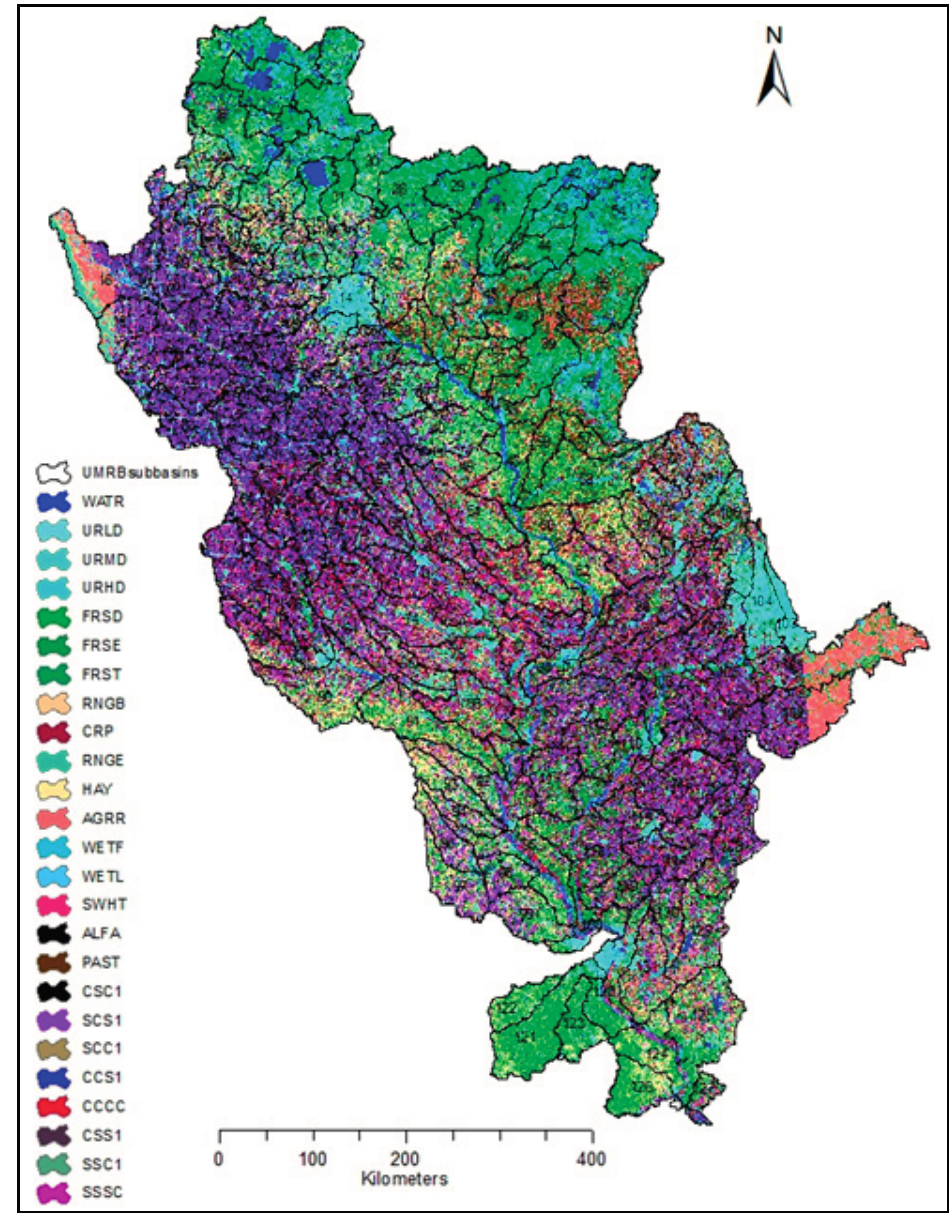
Figure 2. Landuse map for the Upper Mississippi River Basin